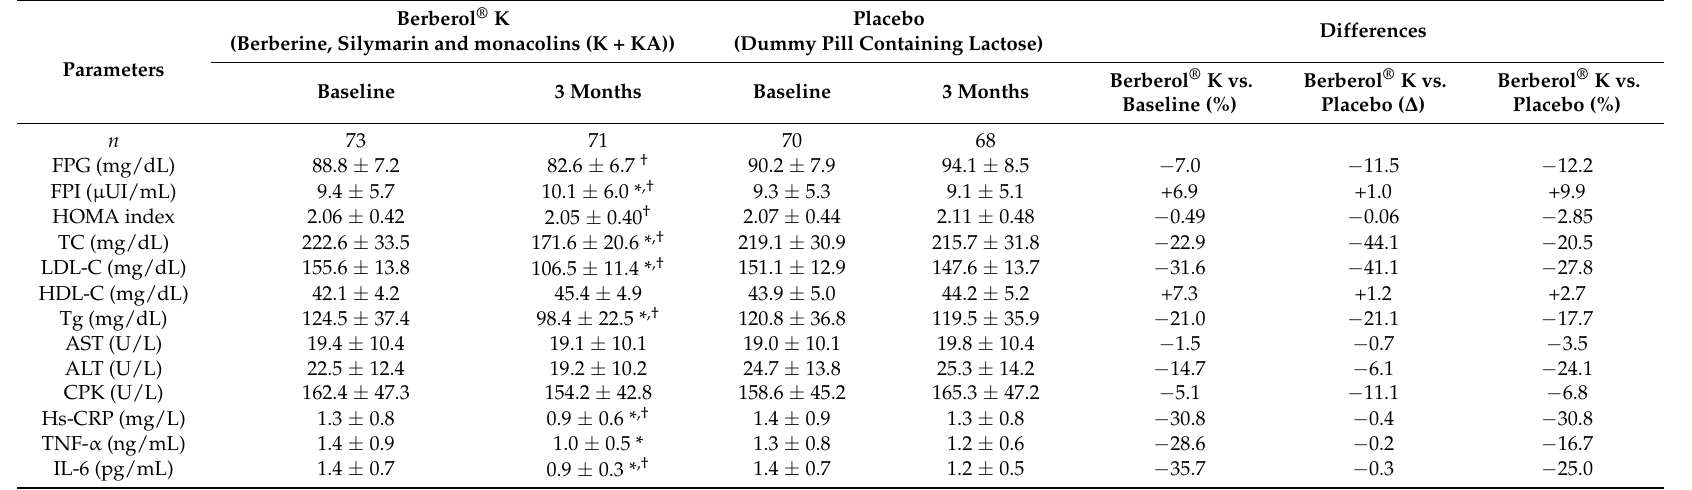
Placebo (Dummy Pill Containing Lactose)